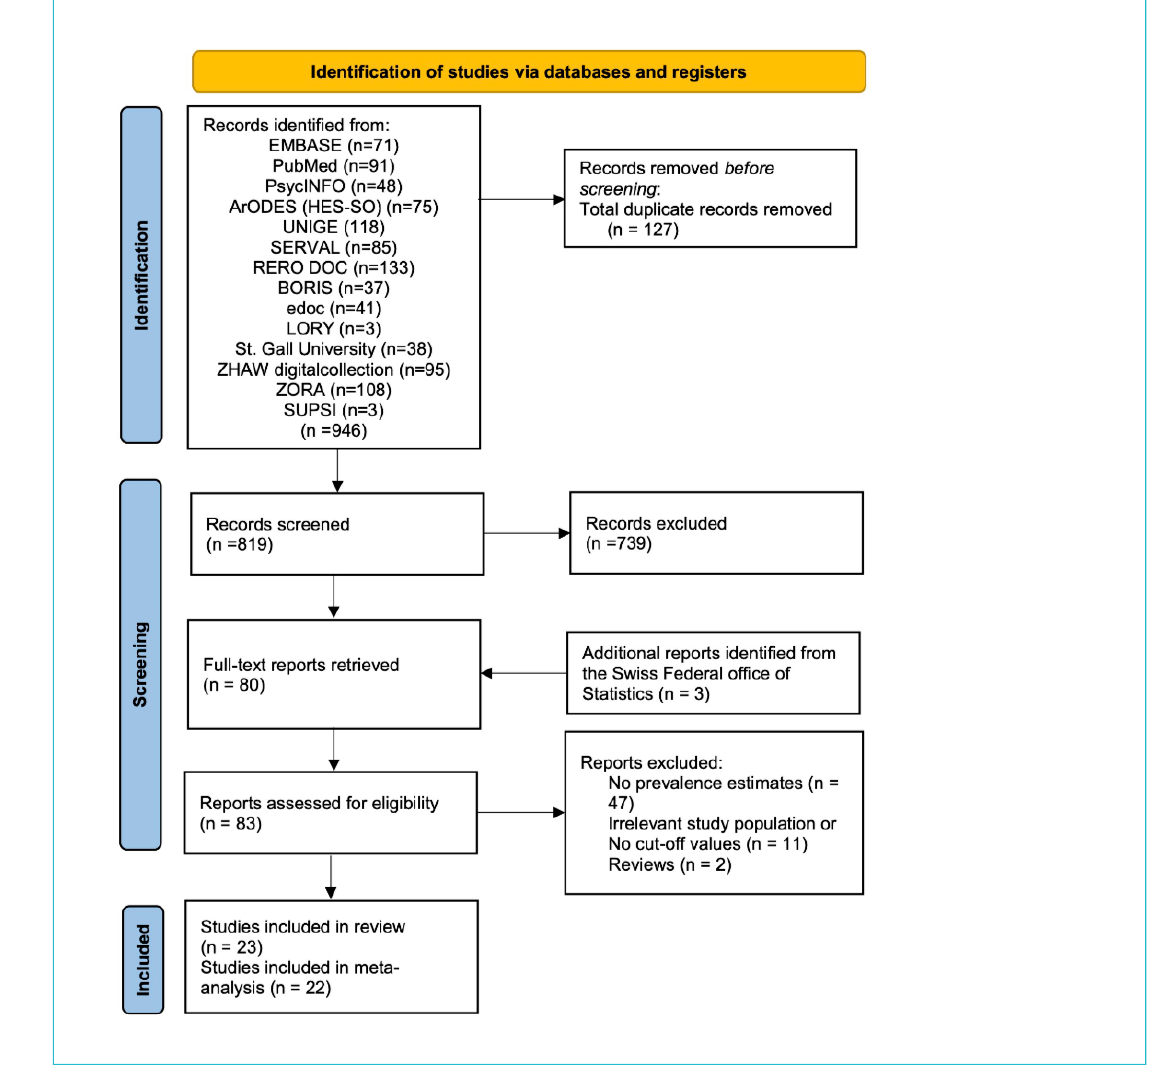
Figure 1: Flowchart of included studies. ArODES (HES-SO): Archive ouverte des HES de Suisse occidentale; SERVAL: Serveur académique lausannois; RERO DOC: Dépô t institutionnel des institutions membres de RERO; BORIS: Bern Open Repository and Information System; edoc: Institutional Repository University of Basel; LORY: Lucerne Open Repository; Université St. Gall: Plateforme de recherche Alexandria; ZORA: Zurich Open Repository and Archive; SUPSI: La Scuola universitaria professionale della Svizzera